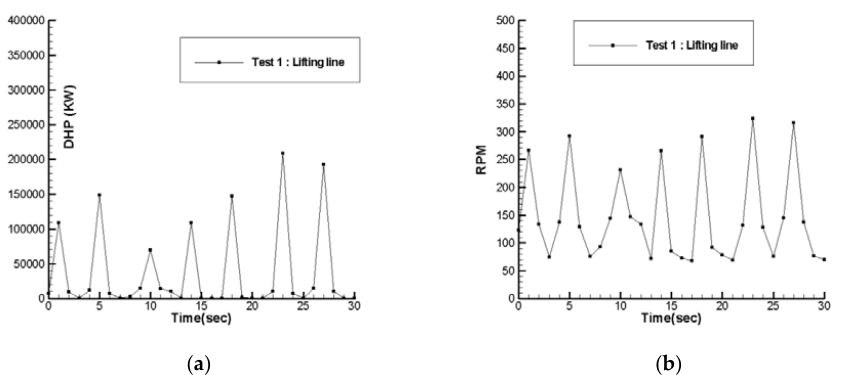
Figure 28. Time history of the required DHP ( a ) and RPM ( b ), numerical experiment #1.